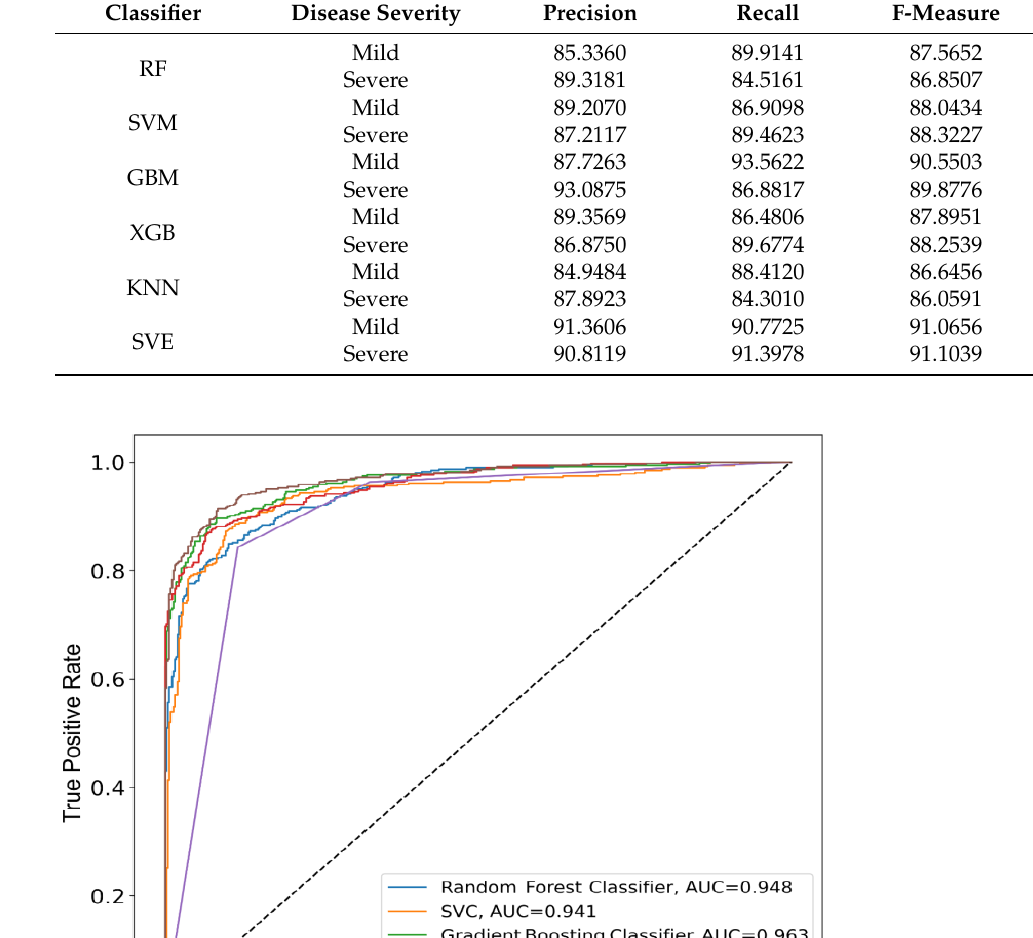
Table 6. Overall performance of all classifiers (%).